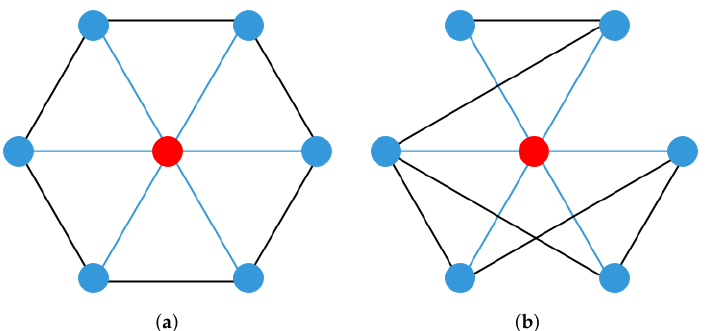
Figure 4. ( a ) Add the central node (red circle) to the network of 6 nodes (blue circle), the central node has connected edges with any other node in the network. ( b ) Perform a disconnect–reconnect operation on the network, no operation is performed on the connected edges of the central node with other nodes during the